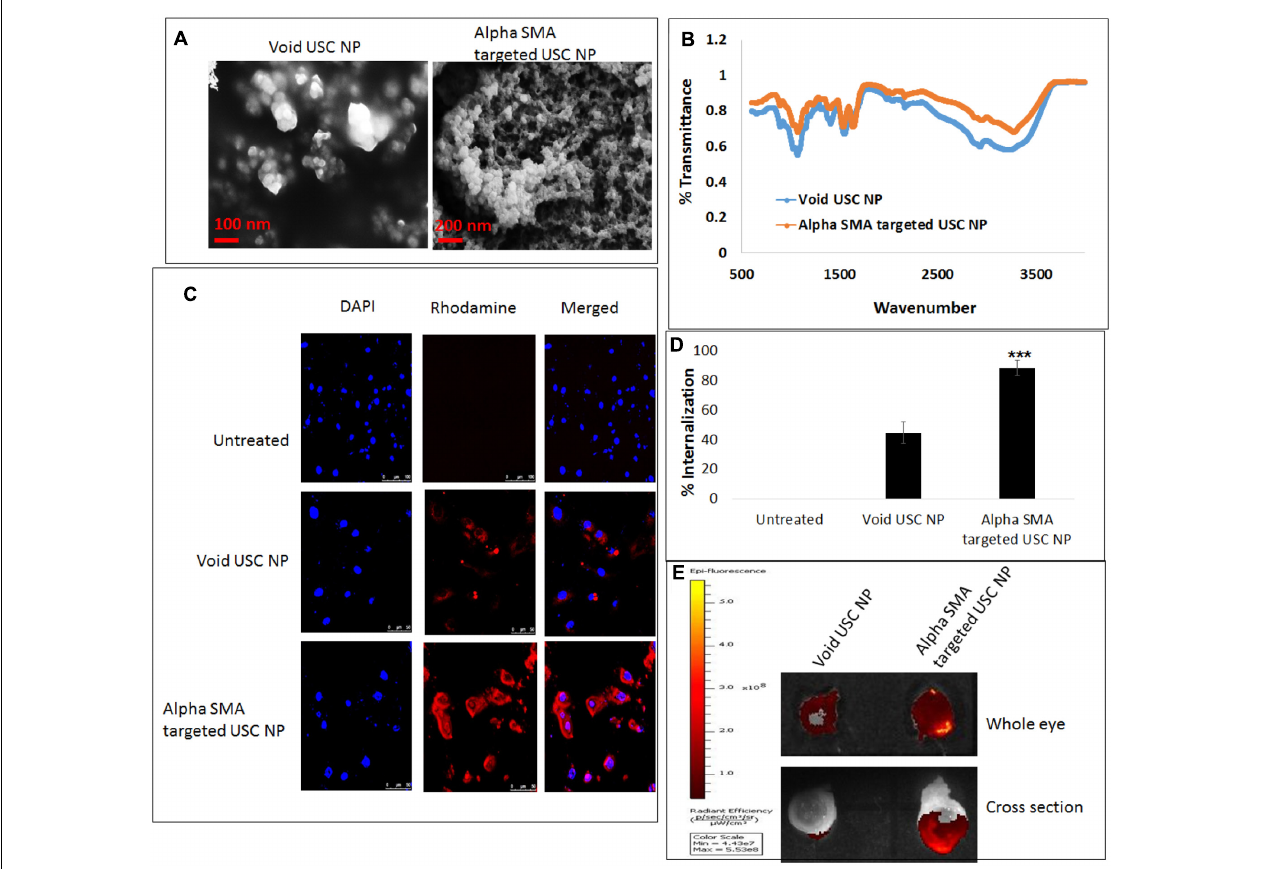
FIGURE 6 | In vitro and ex vivo internalization efficacy of alpha-SMA targeted USC NPs: (A) SEM images confirmed uniform shape and size (50–60 nm) of both void and alpha-SMA targeted USC NPs. (B) FTIR analysis confirmed successful conjugation of anti-body represented by the sharp primary amine peak at 1640 cm - 1 in spectra of alpha-SMA targeted USC NPs. (C) Confocal microscopy revealed that alpha-SMA targeted USC NPs showed substantially higher internalization in MIOM-1 cells when compared to void USC NPs. (D) Graphical representation of confocal images showing internalization efficacy of alpha-SMA targeted USC NPs over void USC NPs. (E) Ex vivo internalization analysis also confirmed that alpha-SMA targeted USC NPs showed higher internalization efficacy than void USC NPs. The experiments were conducted in triplicates. Five images of each treatment were taken for immunofluorescence studies and a representative image has been presented. ∗∗∗ p <